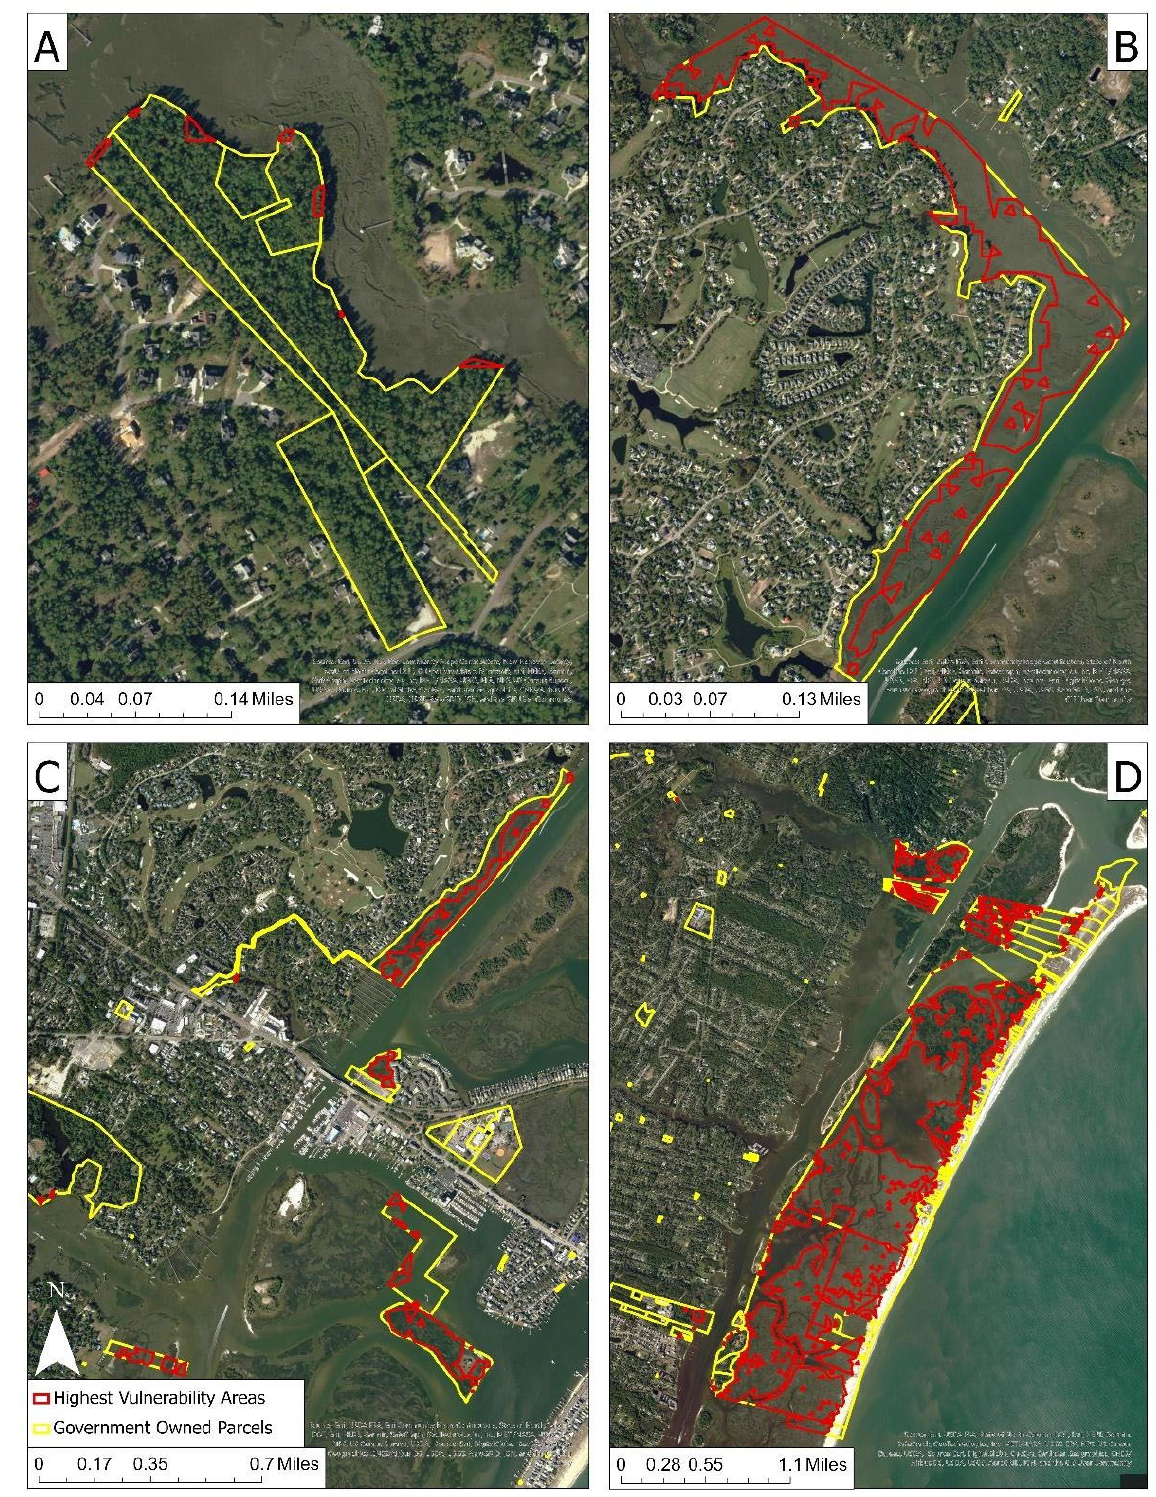
Figure 8. Overlap between the highest vulnerability areas and government-owned parcels of the Masonboro Island–Mason Inlet superimposed on NAIP imagery; ( A ) shows the Page’s Creek area, ( B ) shows the Howe’s Creek area, ( C ) shows the areas around Wrightsville Beach before the main island, and ( D ) shows Masonboro Island.